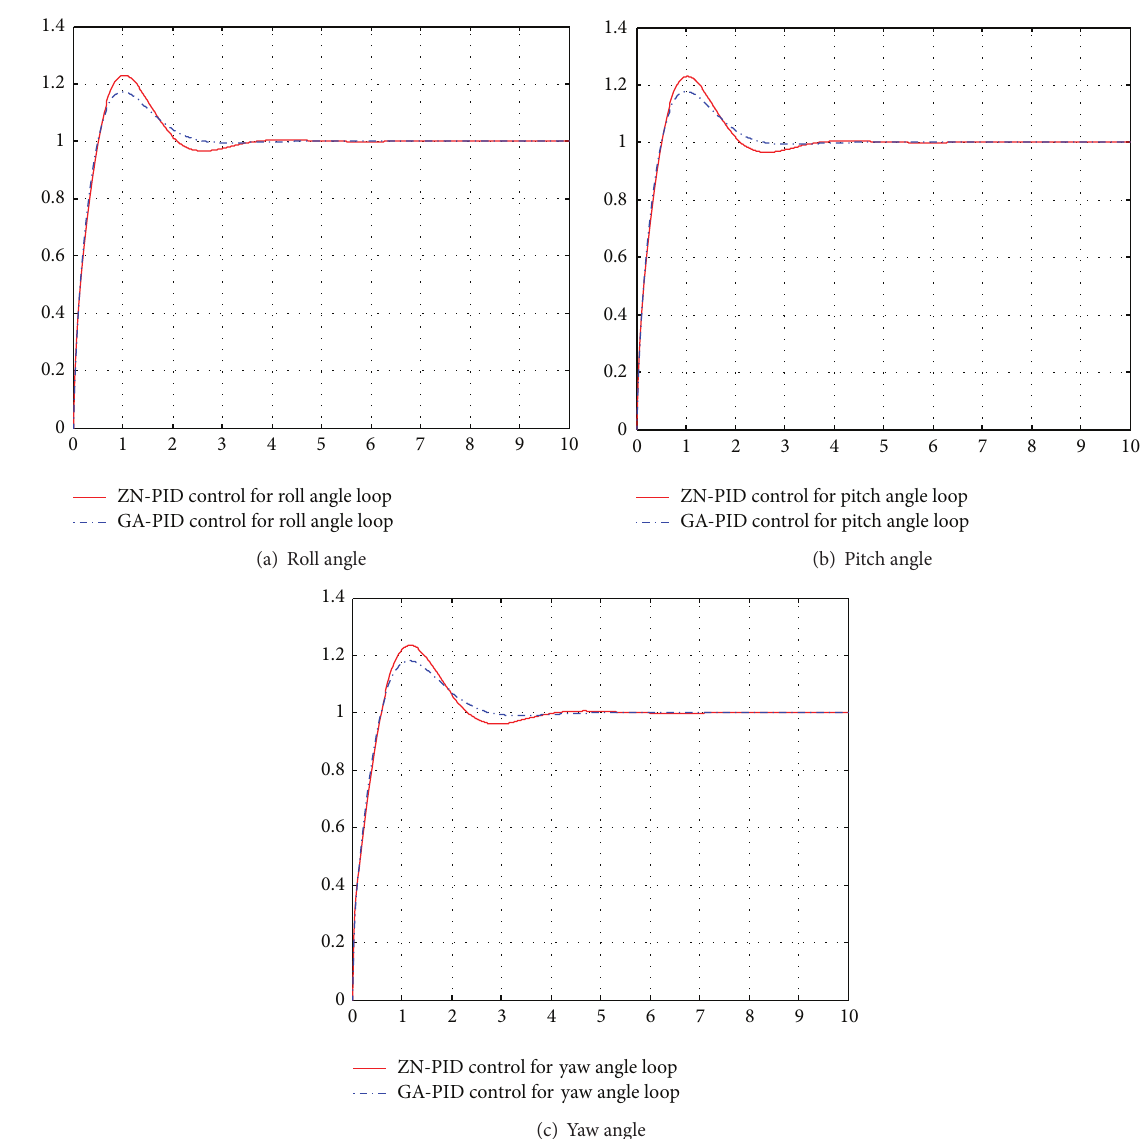
Figure 5: The control effects compare diagrams between ZN-PID and GA-PID for three attitude angles. (a) The control effects compare diagram of the roll angle loop. (b) The control effects compare diagram of the pitch angle loop. (c) The control effects compare diagram of the yaw angle